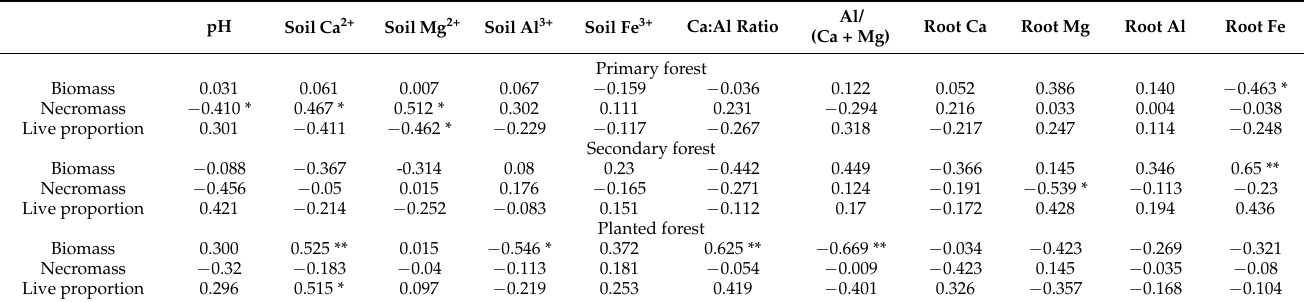
Table 4. Pearson’s correlation coefficients among soil and fine root